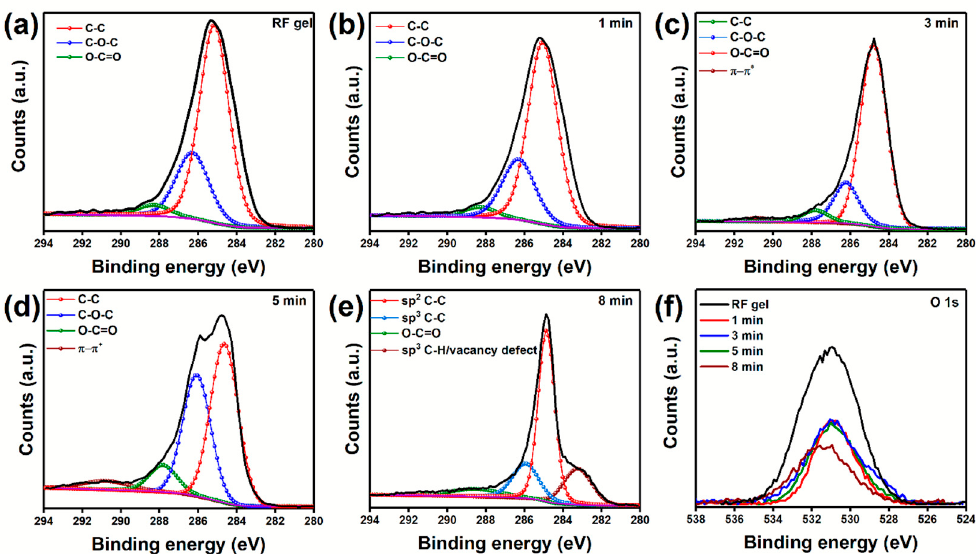
Figure 5. High-resolution C 1s spectra of RF gel and CNs obtained after the time-dependent plasma surface treatment at a power of 250 W and flow rate of 100:50 sccm: ( a ) RF gel ( b ) 1 min; ( c ) 3 min; ( d ) 5 min; ( e ) 8 min; and ( f ) O 1s spectra of RF gel and CNs after each stage of plasma surface treatment.